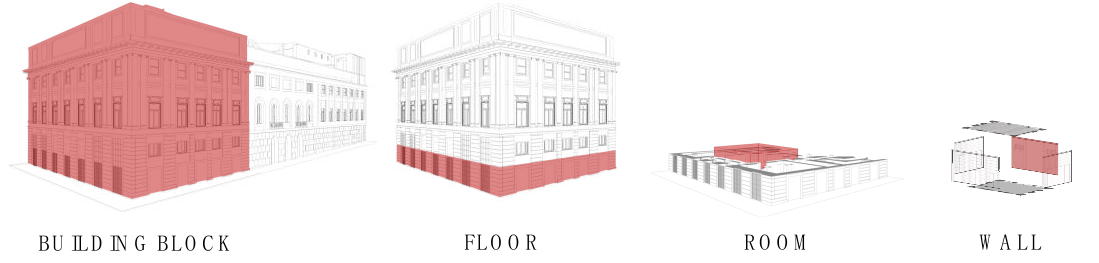
Figure 7. Theater space breakdown structure.